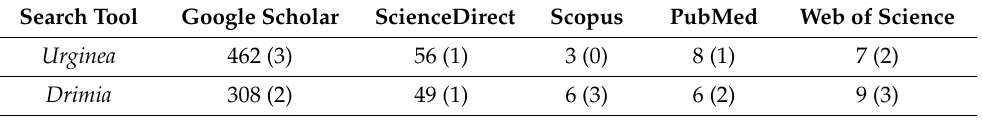
Table 3. Results of the Database Search on Urginea, Drimia and toxicity from 2017 to 2021. Search